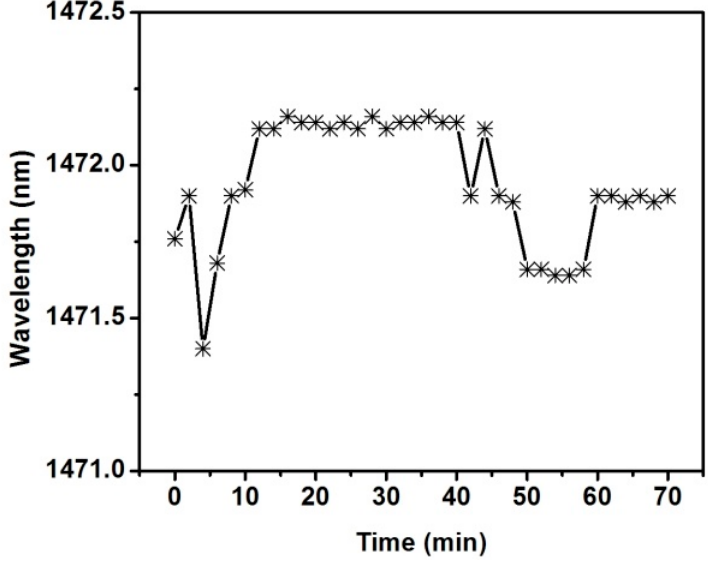
Figure 9. Resonant wavelength versus time.